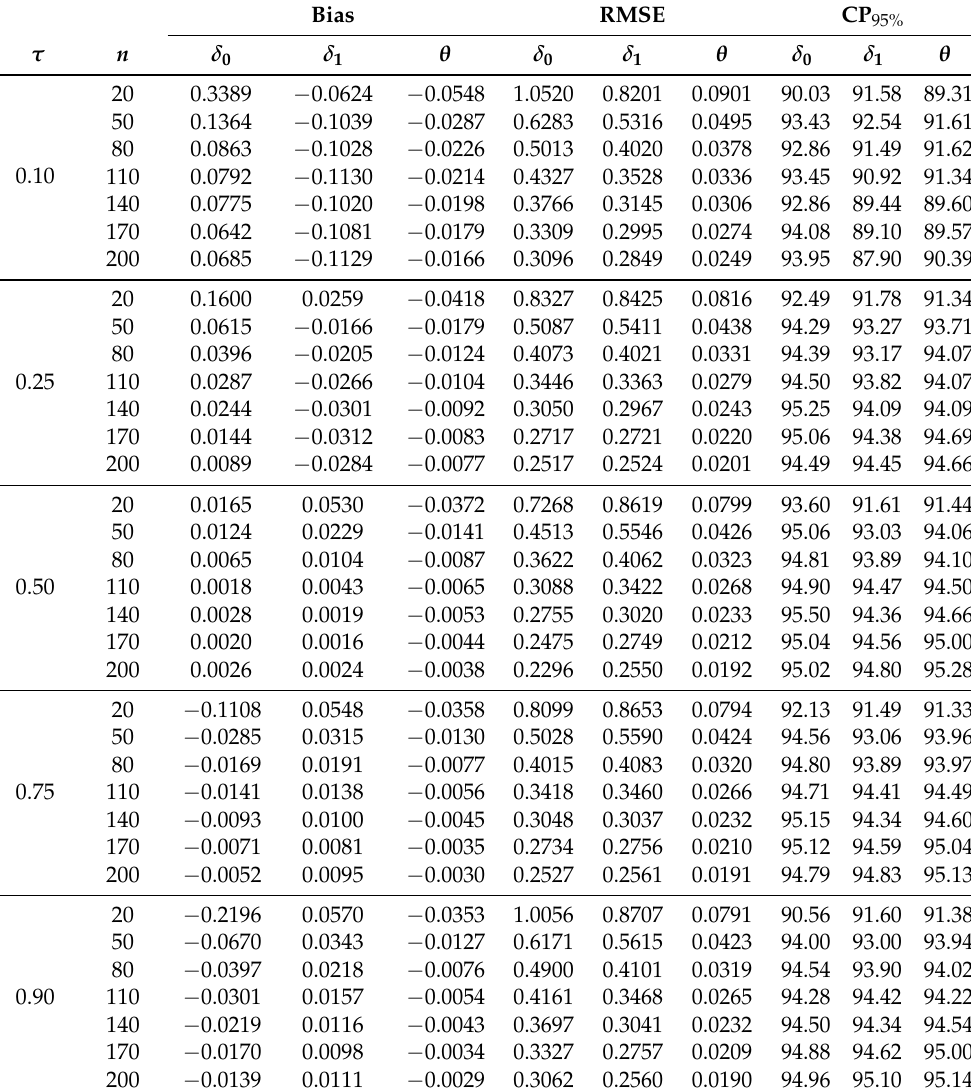
Table 3. Empirical bias, RMSE, and 95% CP (true values: δ 0 = 1.00, δ 1 = 2.00, and θ = 0.75) with simulated